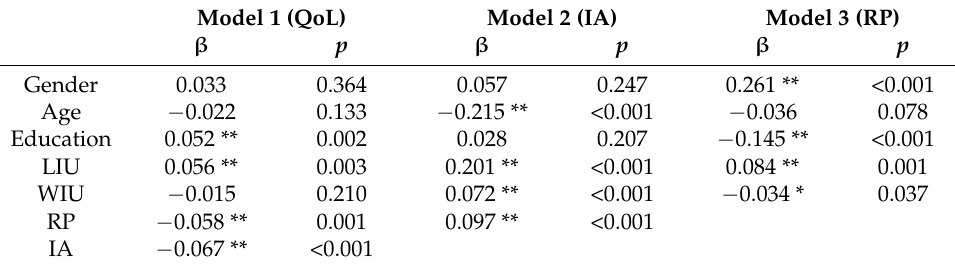
Table 4. Regression results on QoL, RP, and IA.